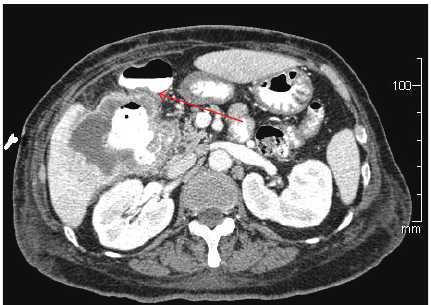
Figure 3: SCC of the gallbladder with fistula to the hepatic flexure of the colon.